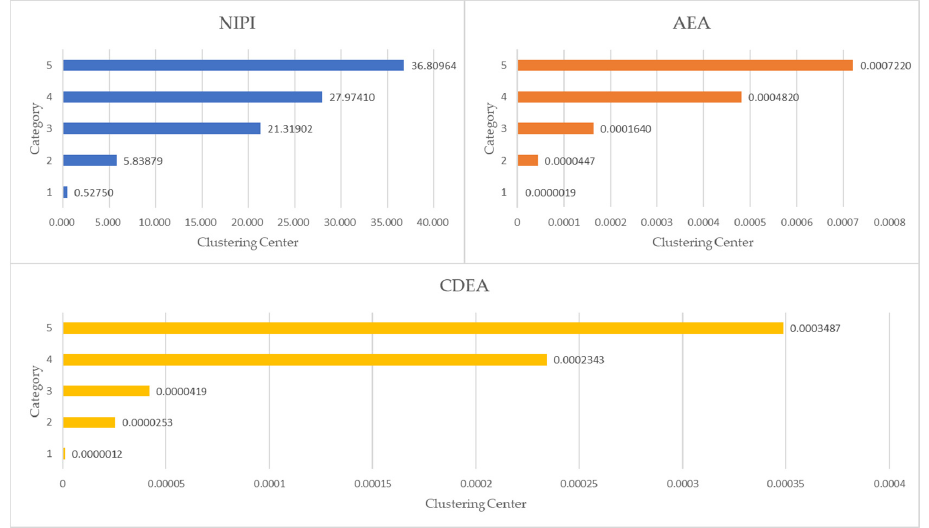
Figure 6. Distribution of different indexes in five cluster centers.